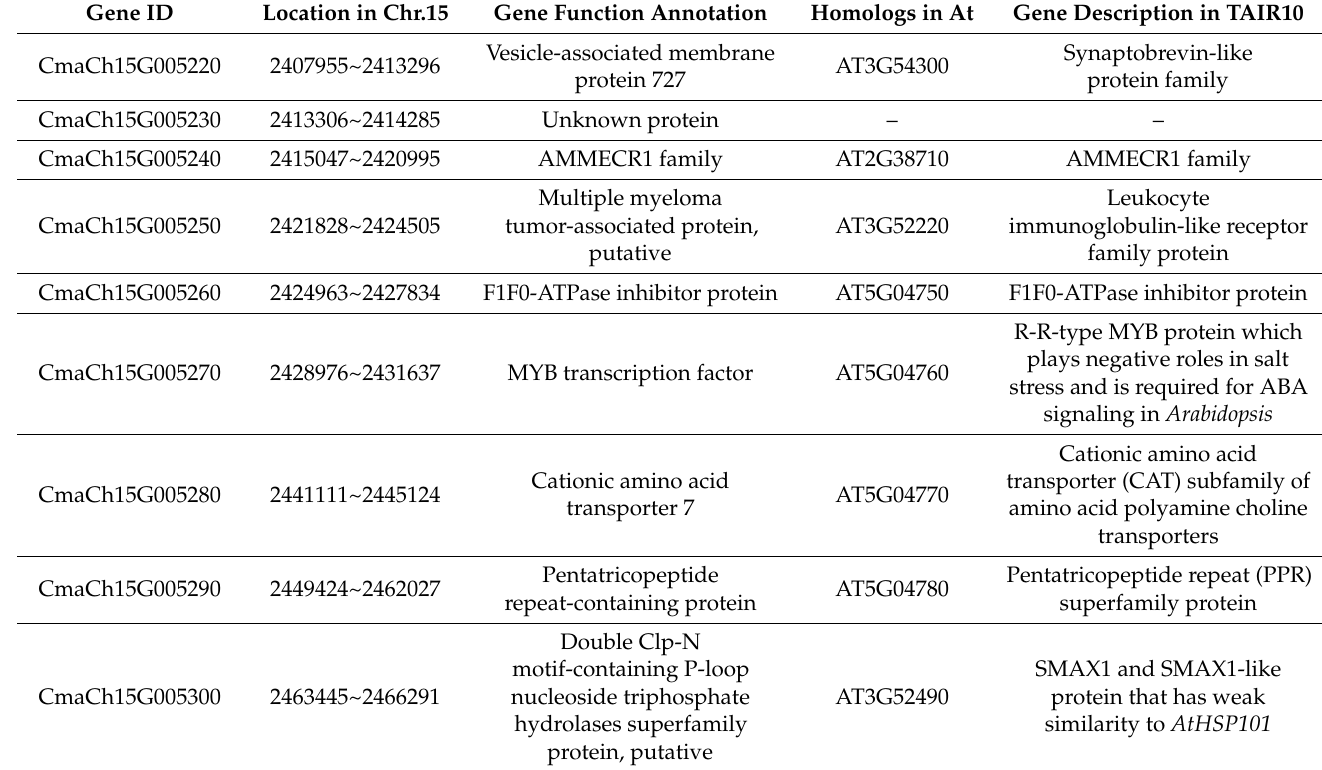
Table 3. Annotation and homologs of candidate genes in Arabidopsis thaliana.